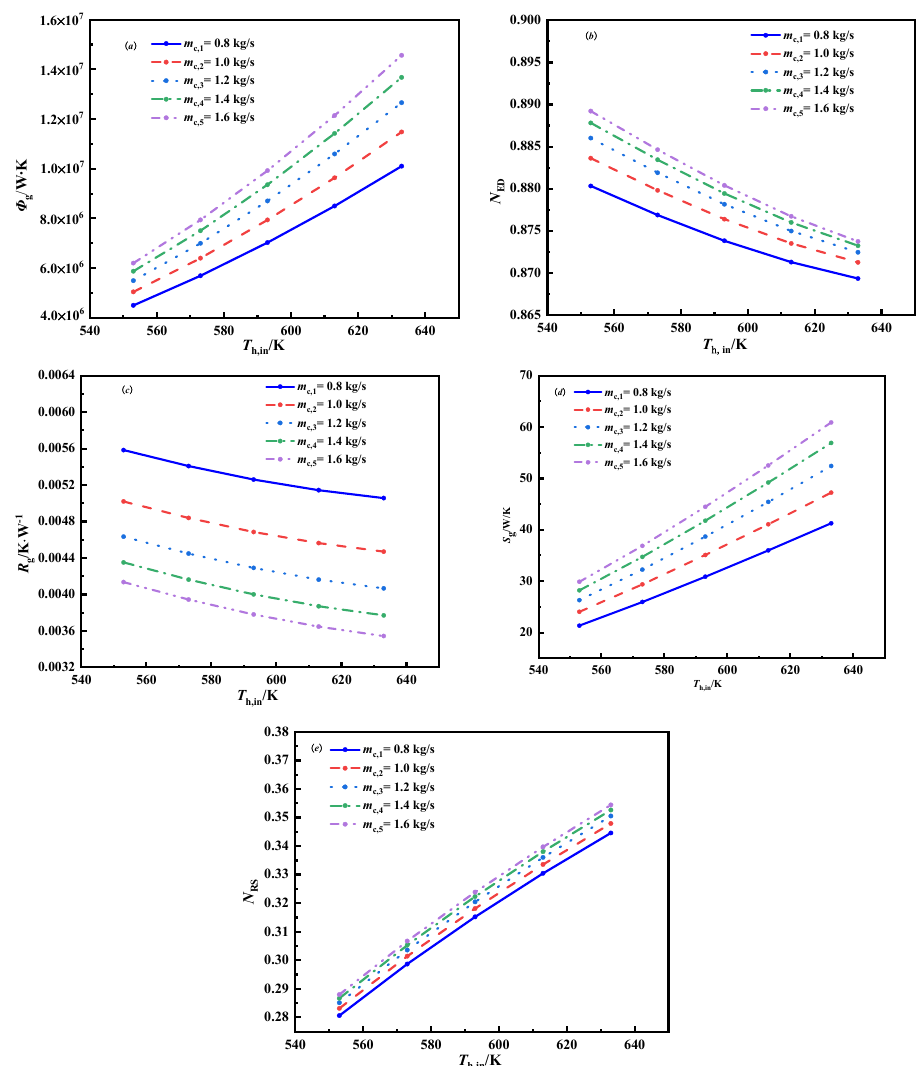
Figure 5. The 𝜙 ( a ), 𝑁 ED ( b ), 𝑅 g ( c ), 𝑆 g ( d ), and 𝑁 (cid:2902)(cid:2903) ( e ) versus the inlet mass flow rate of sCO g